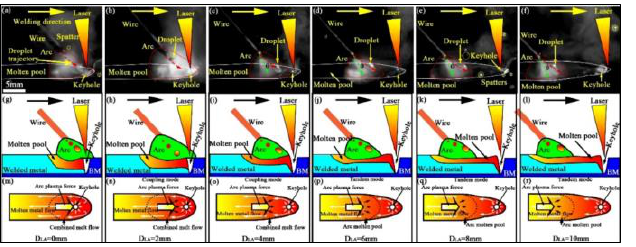
Figure 10. Influence of D LA on heat source coupling effect. ( a – f ): high-speed image analysis; ( g – l ): corresponding mechanisms from cross-section view; ( m – r ): corresponding mechanisms from top-side view [60]. Reprinted with permission from [60] 2020